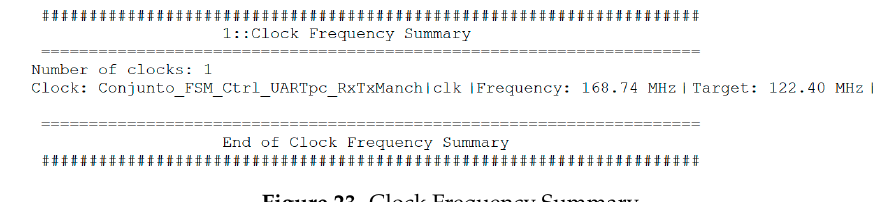
Figure 22. DALI Bridge response time including communication time.